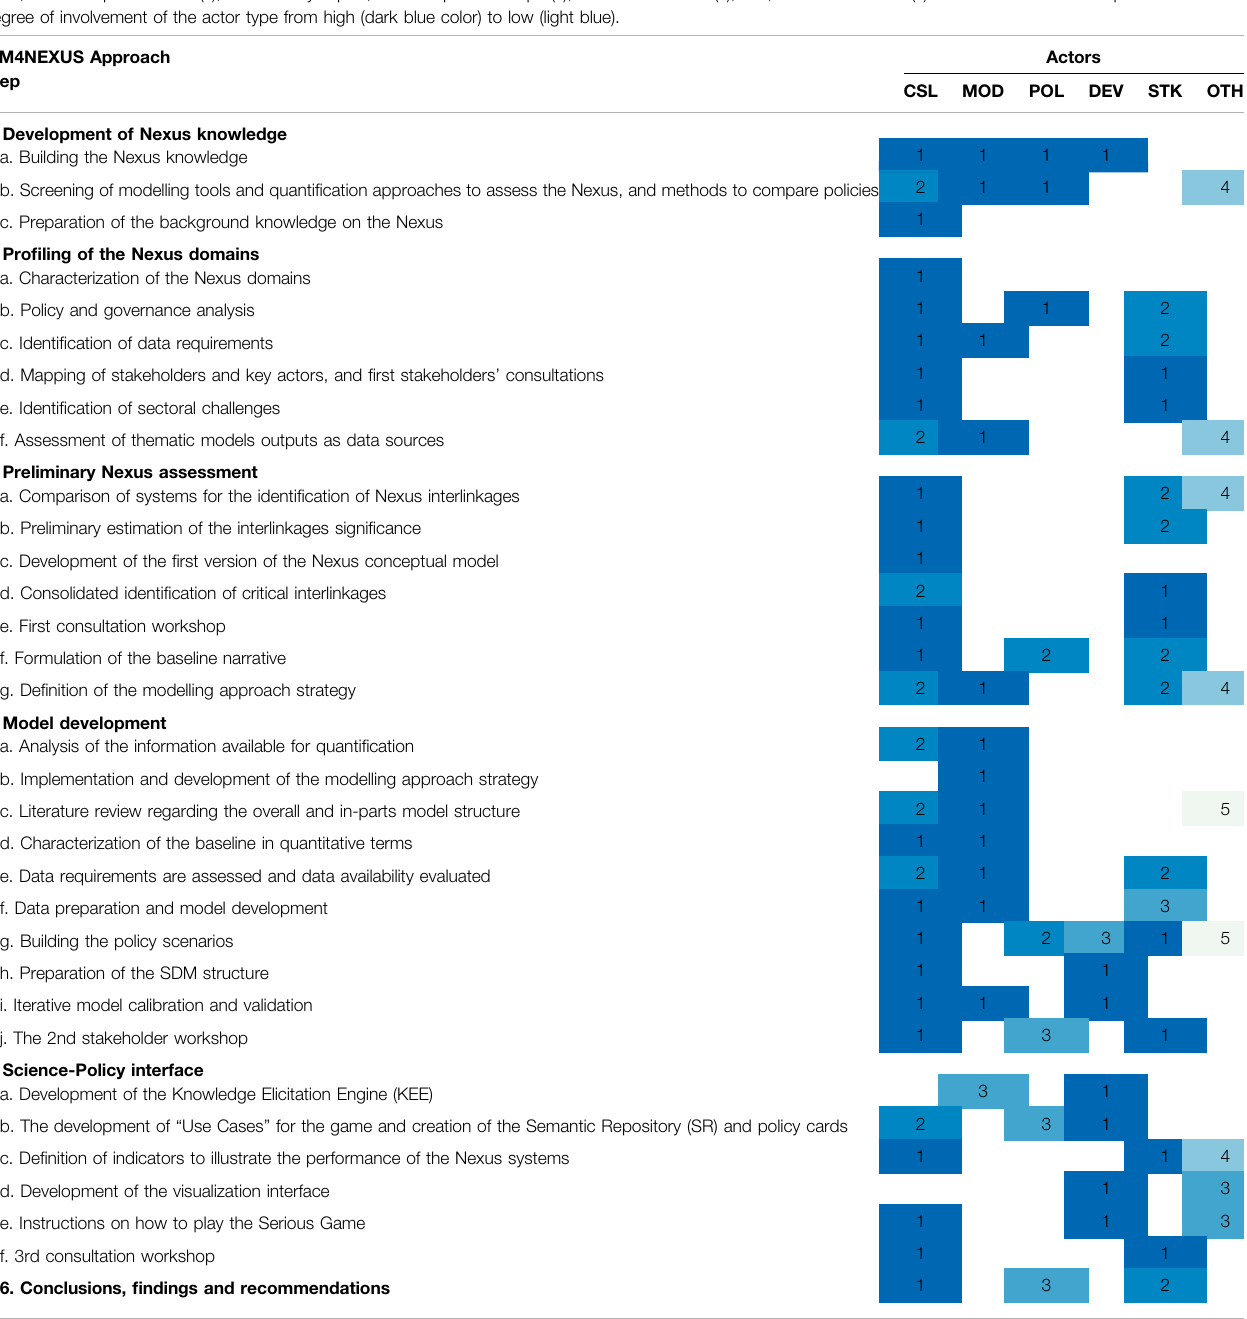
TABLE 2 | Overview of actors involved in the different steps of the SIM4NEXUS approach and the intensity of their participation. Abbreviation meaning: CSL — CS Leading team;MOD — ExpertModeller(s);POL-PolicyExpert;DEV — ExpertDeveloper(s); STK — Stakeholder(s); and,OTH — Otheractor(s). Thecolornotation “ x ” expressesthe degree of involvement of the actor type from high (dark blue color) to low (light